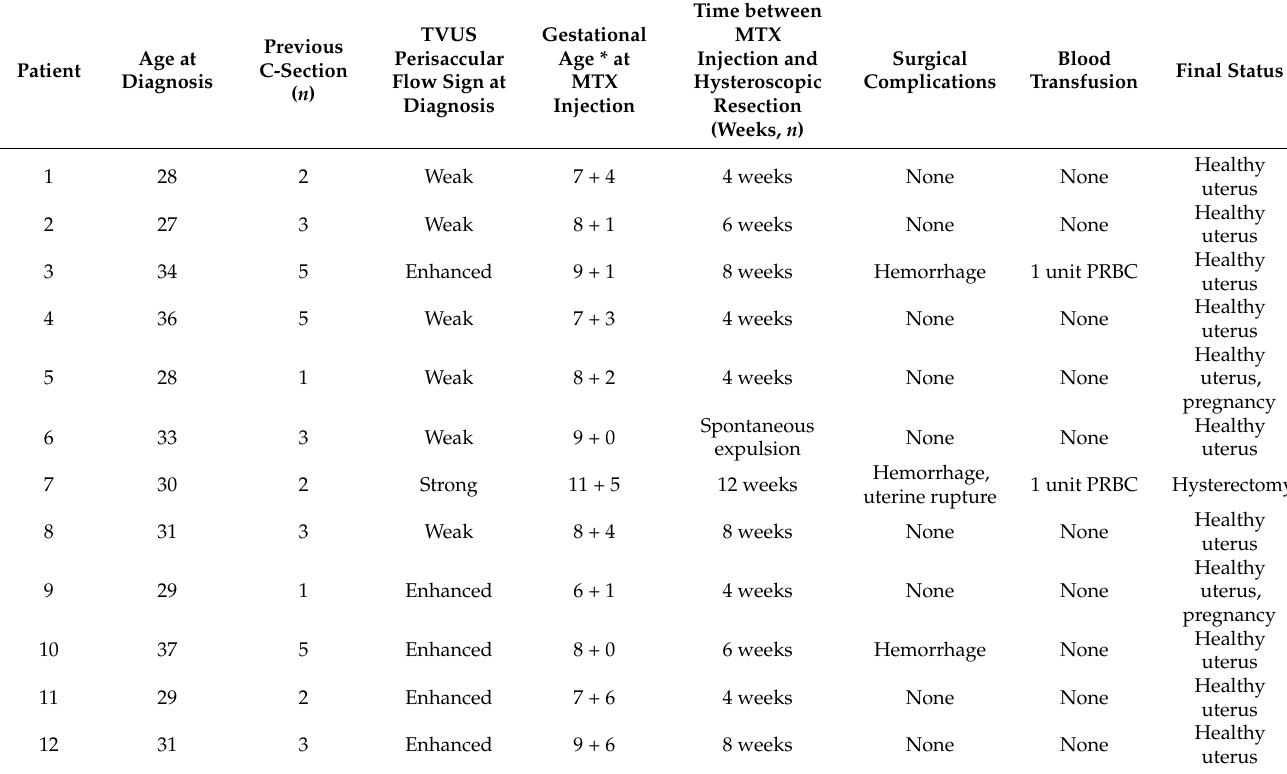
Table 1. Clinical characteristics, procedure details and outcomes of the study